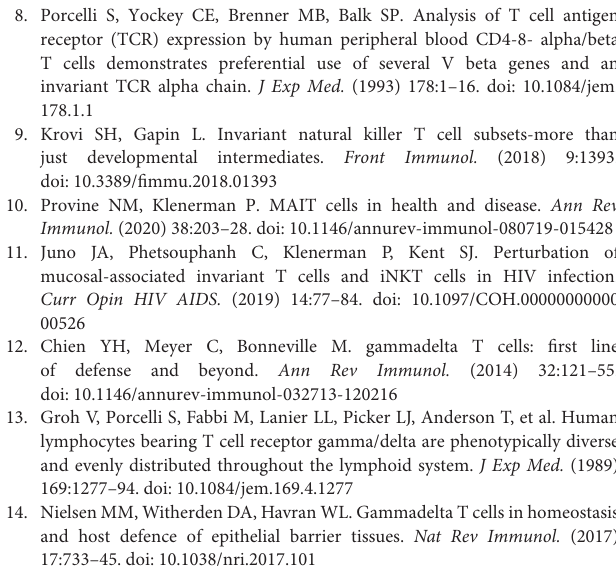
Supplementary Figure 1 | (A) Gating strategy of blood, duodenum and colon gut tissue samples as lymphocytes/singlets/live/CD45 + /CD3 + then gated for gdTCR/Va7.2 before unsupervised clustering using Cytographer, Immunoscape. (B) Relative frequency of each of the 21 clusters for colon, duodenum and blood and shown in (C) as stacked bars for each compartment and color-coded by cluster ID. Supplementary Figure 2 | Relative staining intensity of each marker in 36 markers used for sub-clustering using Cyographer software with all samples combined into one UMAP plot. Phenograph UMAP (last plot) identifies each cluster 1–20. Supplementary Table 1 | Clinical information of all individuals participants included in the study ( n = 111). Supplementary Table 2 | TCRs found in blood ( n = 33). Supplementary Table 3 | TCRs found in duodenum ( n = 21). Supplementary Table 4 | TCRs found in colon ( n = 12). Supplementary Table 5 | CDR3 sequences with 50% or more overlap between colon samples and their presence in duodenum samples shown as percent sharing (donor